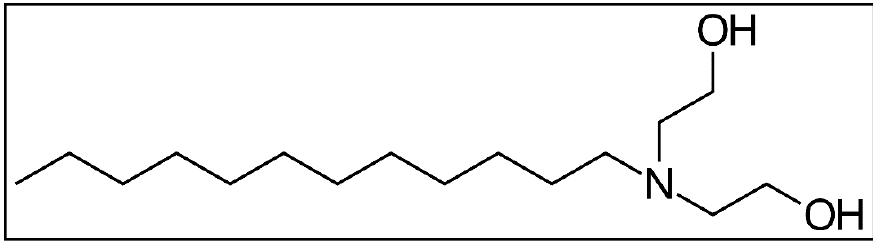
Figure 1. Chemical structure of the surfactant used in this study. The hydrophobic tail contains 12 carbon atoms.